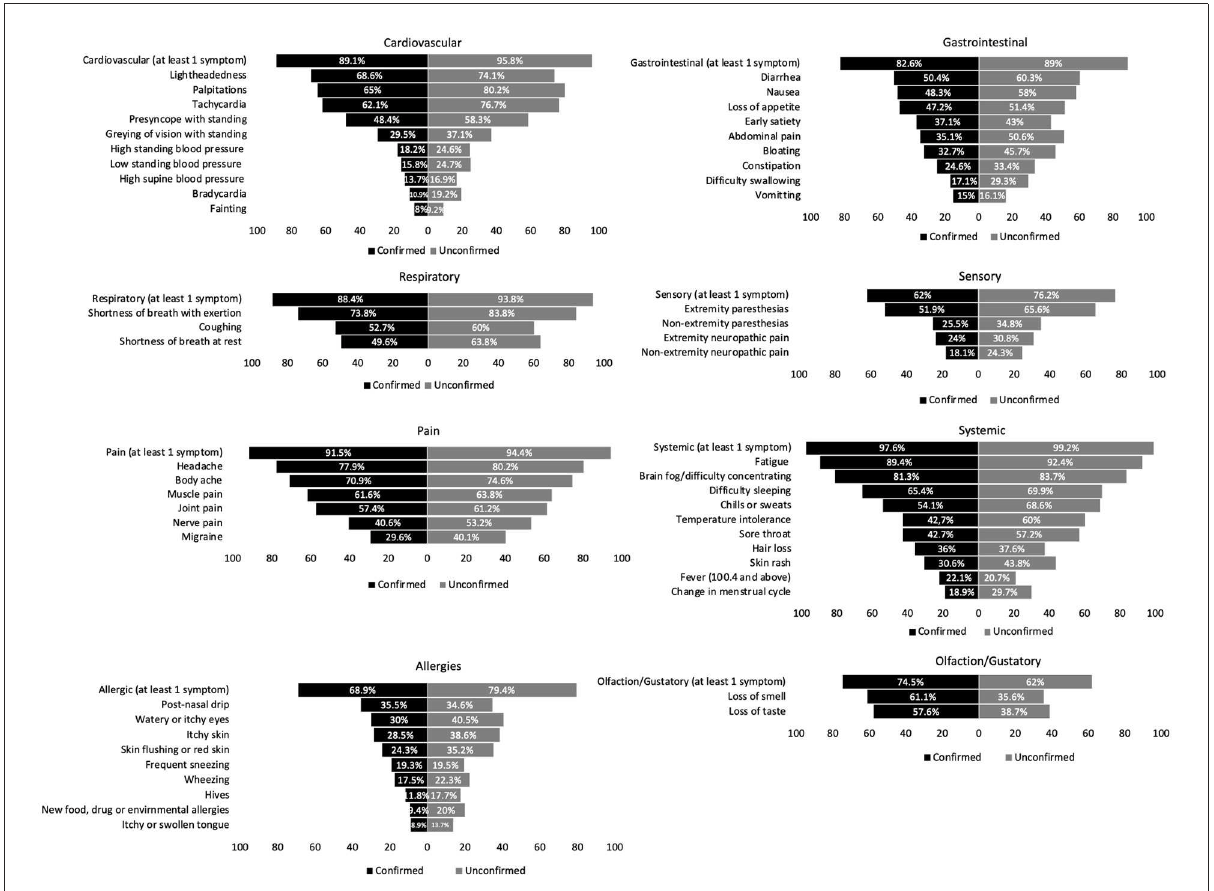
FIGURE2 Prevalence of PASC